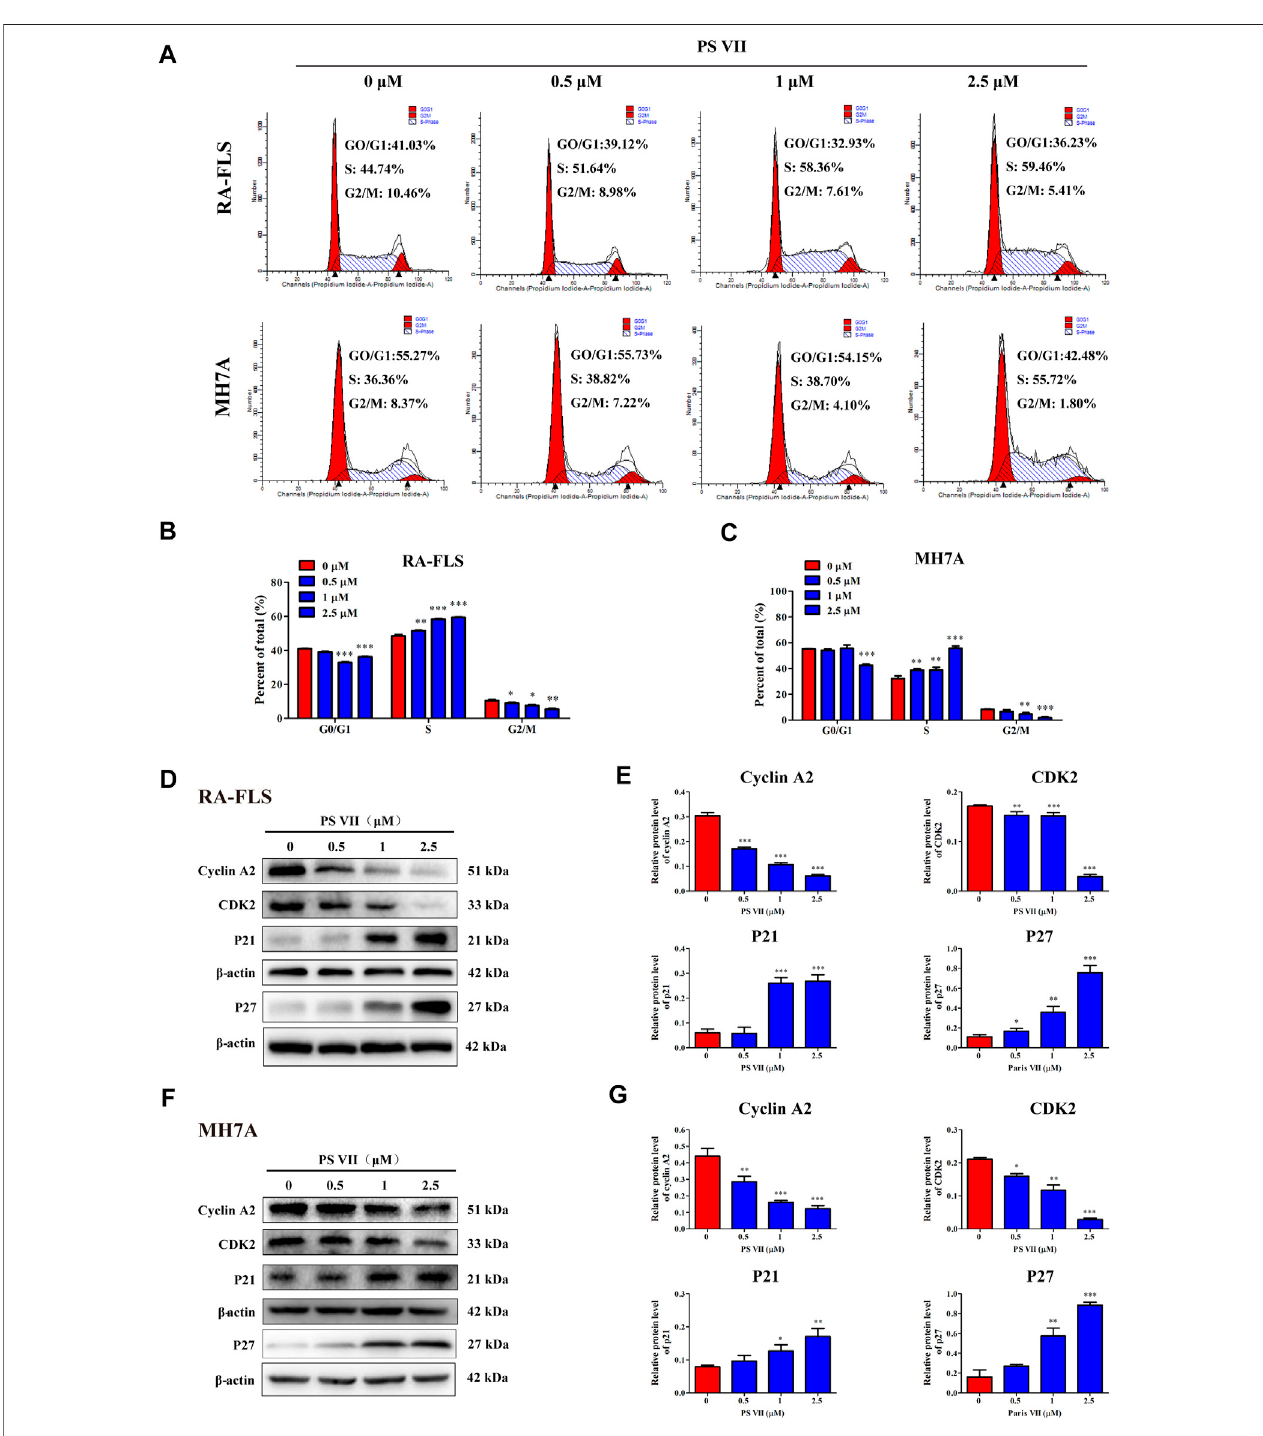
FIGURE 2 | Effects of PS VII on cell cycle in RA-FLS and MH7A cells. RA-FLS and MH7A cells were treated with PS VII (0, 0.5, 1, 2.5 μ M) for 48 h. (A) Cell cycle distributionwasassessedby fl owcytometry. (B,C) Theproportion ofcellsinG0/G1,G2/M,andSphases. (D,F) ExpressionlevelsoftheSphaserelatedproteinscyclin A2, CDK2, P21, P27 were detected by Western blot. (E, G) The relative expression of protein in RA-FLS and MH7A cells was determined by optical density analysis. Image J was used to determine the density ratio of each protein band relative to β -actin. Compared with the control group, * p < 0.05, ** p < 0.01, *** p < 0.001.